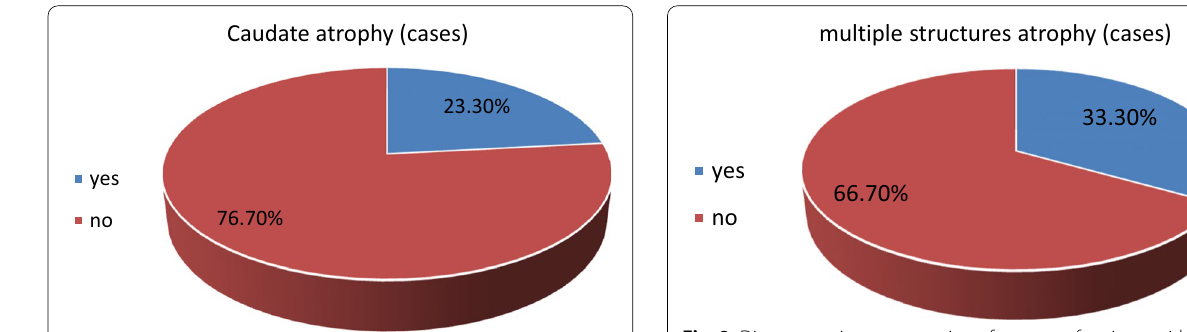
Fig. 8 Diagrammatic representation of percent of patients with multiple structures atrophy